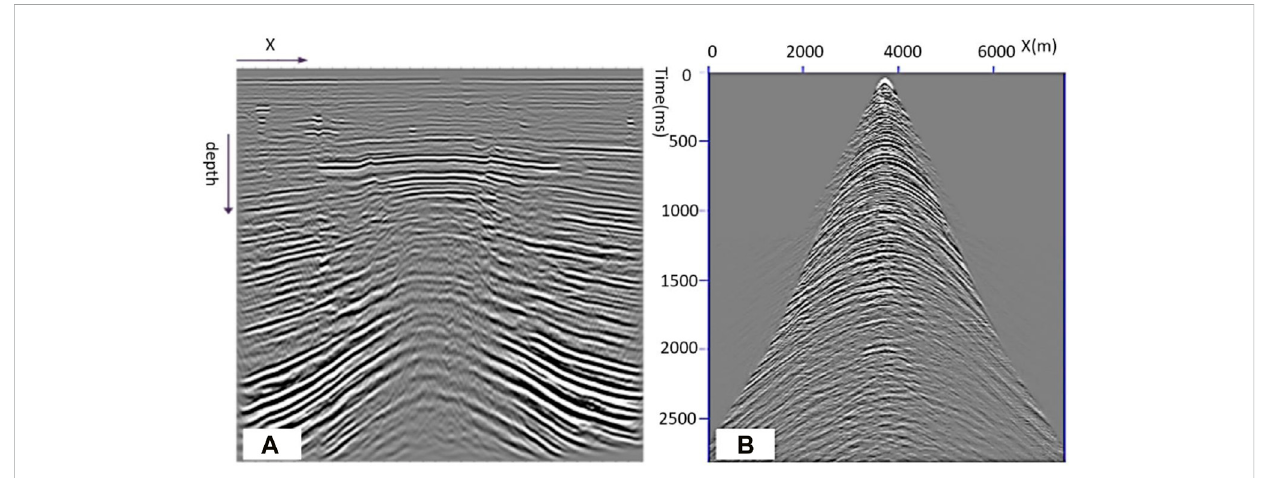
FIGURE 3 2DOBNdatasetfromaMalaysian fi eld. (A) PSDMstackshowsawipe-outzoneunderthegaslayers. (B) InputshotgatherforFWIafterde-ghost, de- signature, and